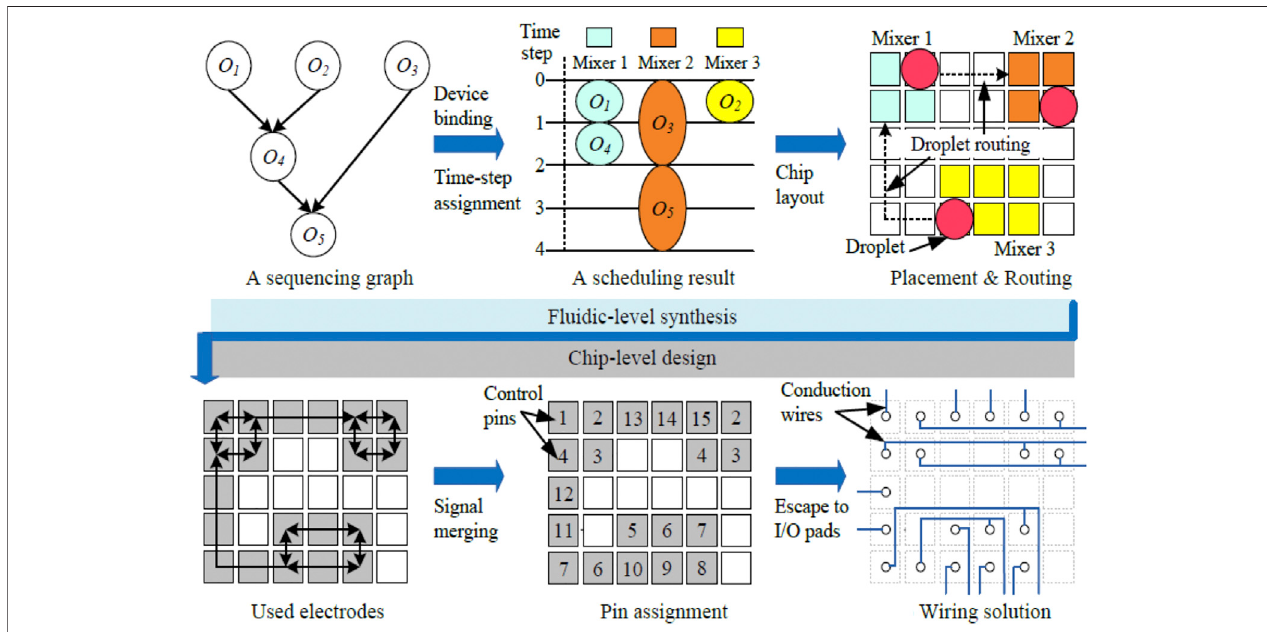
FIGURE 3 | EAD-based design fl ow of electrowetting-on-dielectric (EWOD) chips. A sequence graph de fi nes the droplet manipulation on an abstract level and subsequently goesthrough thetime-stepassignment.TheEADsoftware completes the fl uidic-levelsynthesisbygeneratingthechiplayoutand proceeds intochip-level design with the pin assignment and wiring